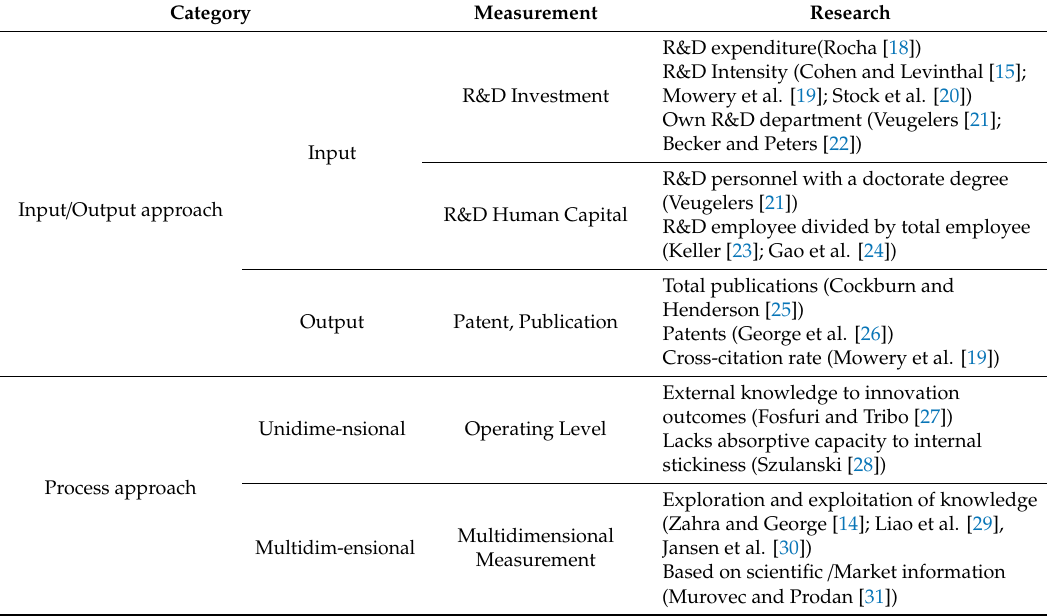
Table 1. Measurement approach of absorptive